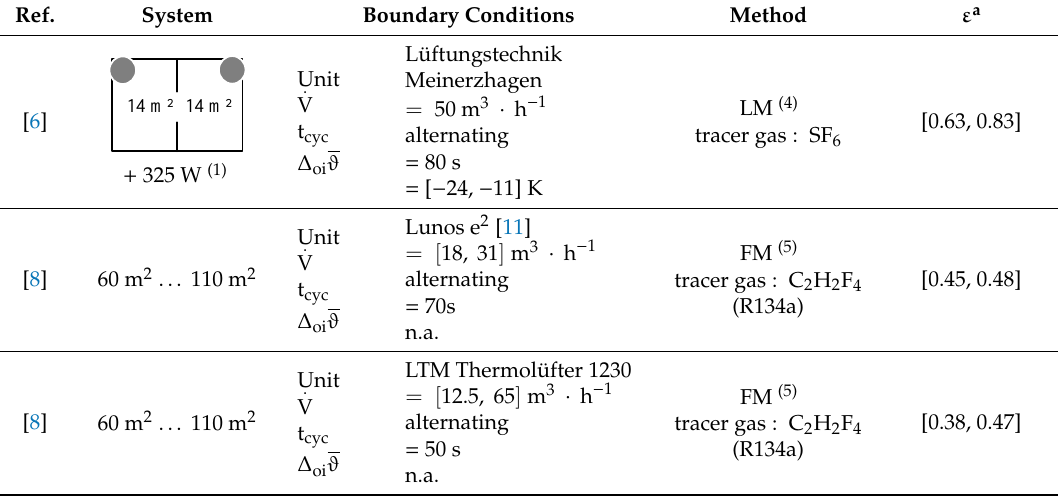
Table 2. Literature review of global air exchange e ffi ciencies ε a , according to Equation (6), in rooms equipped with push-pull device.